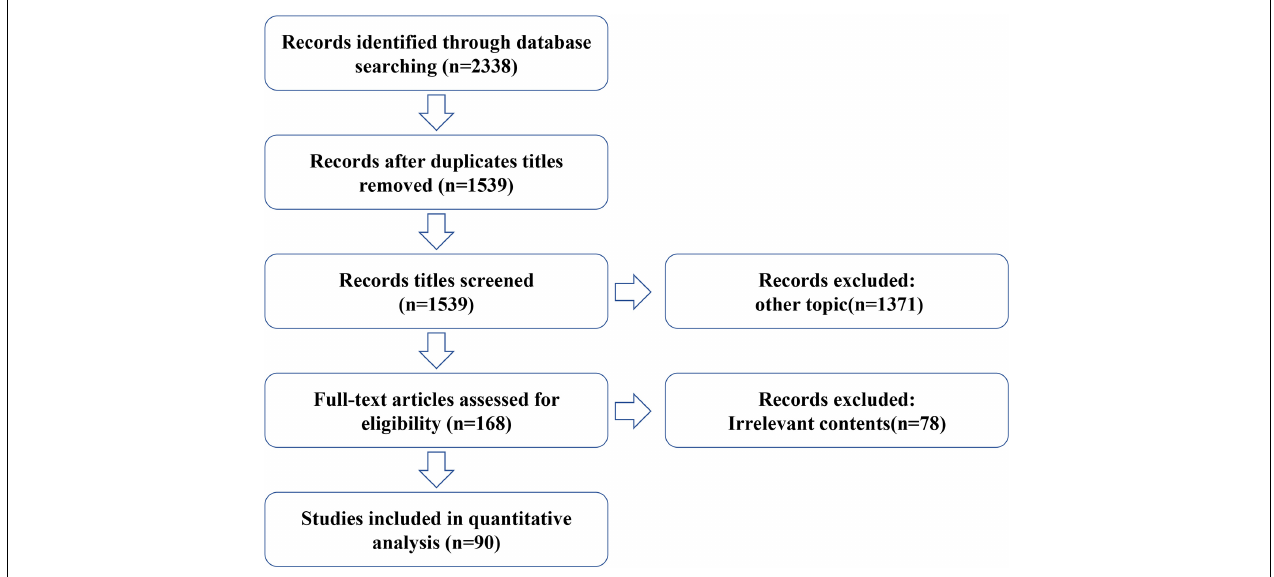
FIGURE 2 | Schematic of study